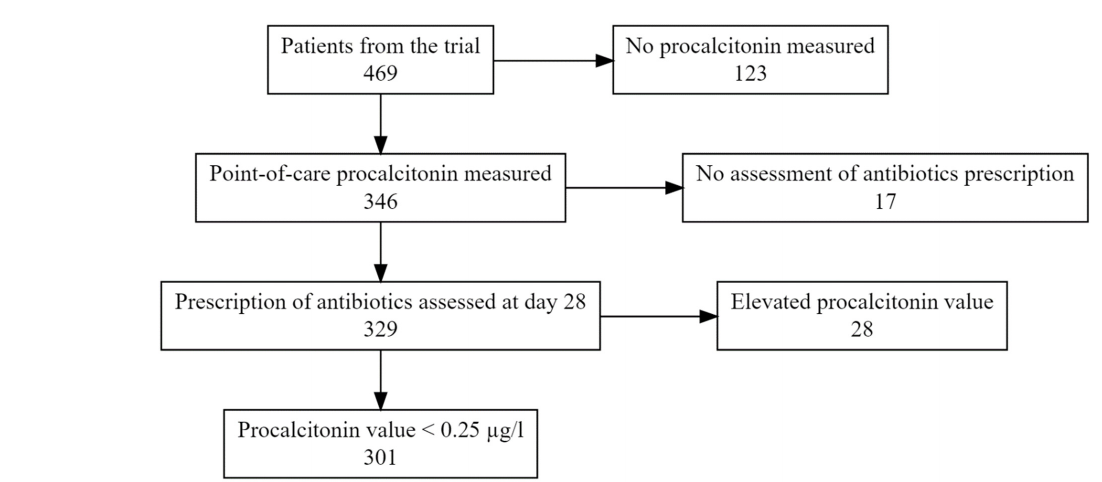
Figure 1. Participants’ flowchart. Table 1. Patients’ characteristics, clinical presentation and general practitioners’ characteristics, ac- cording to the overruling of initial procalcitonin guidance: descriptive statistics and univariate lo- gistic regression models. Values are n (% of the corresponding total number), unless stated other- wise. Odds ratios and p- values were calculated from univariate mixed-effects logistic regression and corrected for clustering.